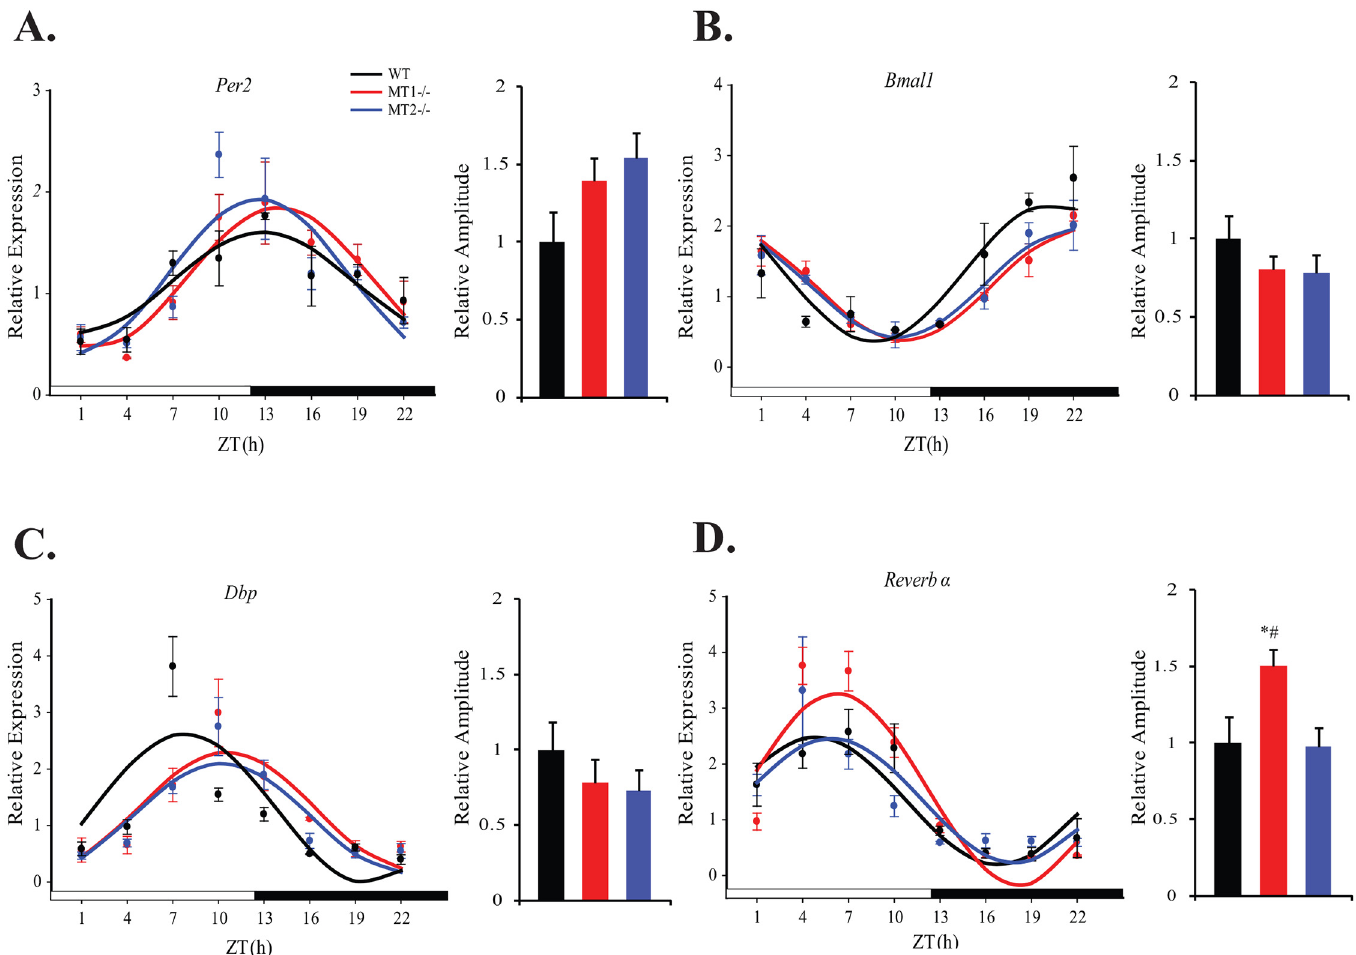
Fig 4. Expression levels of clock and clock controlled genes within adipose tissue of WT, MT1 -/- , and MT2 -/- mice. Daily gene expression levels of Per2 (A), Bmal1 (B), Dbp (C) and Reverb α (D) are depicted above. For each respective plot: the black circle (WT), red circle (MT 1-/- ) and blue circle (MT 2-/- ) indicate the expression levels of target genes calculated relative to the average expression of each dataset throughout the 24hrs. Results are represented as mean ± SEM. The black (WT), Red (MT 1-/- ) and blue (MT 2-/- ) lines represent the periodic sinusoidal functions determined by COSINOR analysis (p < 0.05, (N = 4 – 6 for each time point and genotype). The bar graphs corresponding to each plot depict the amplitude of each oscillating transcript as calculated by COSINOR analysis and normalized to the value of the WT amplitude. * p < 0.05, One-Way ANOVA (post-hoc: Holm-Sidak) WT vs. MT 1 -/- ; # p < 0.05, One-Way ANOVA (post-hoc: Holm-Sidak) MT1 -/- vs. MT 2-/-